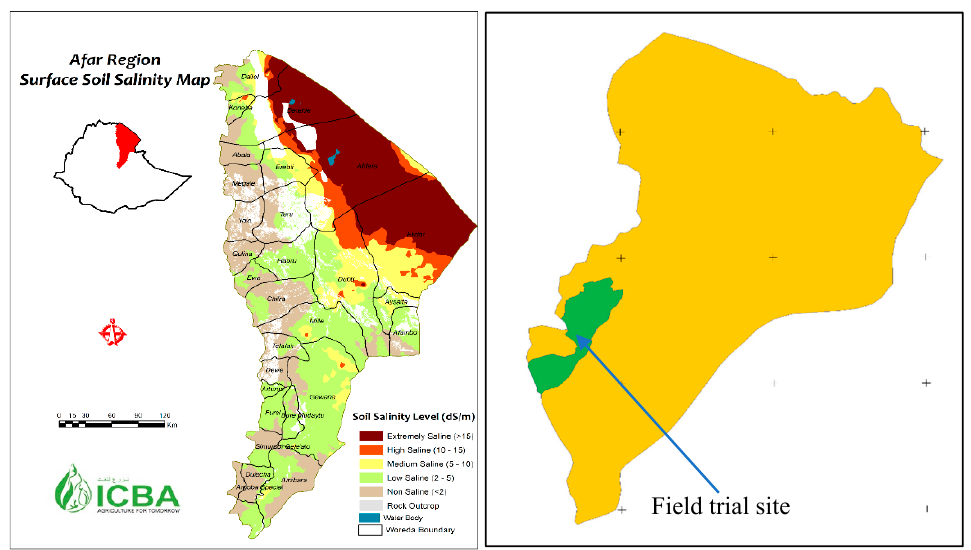
Figure 1. Geographical location of the field trial site.